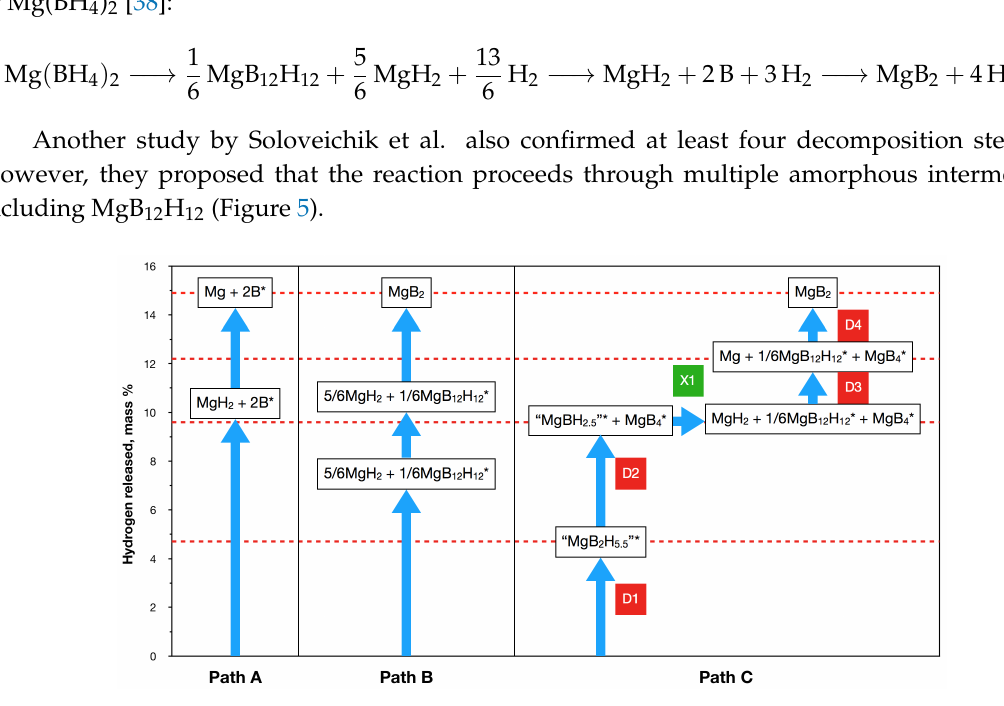
Figure 5. Decomposition pathways of Mg(BH 4 ) 2 , reproduced from Soloveichik et al. (Path C), where D1–D4 indicate hydrogen evolution events measured by temperature programmed desorption (TPD) [76]. Path A [37,77] proposed by Matsunaga et al. and Path B [38] proposed by Li et al. refer to mechanisms described in previous publications. Amorphous phases are denoted by an asterisk, observed hydrogen evolution steps are marked by dashed red lines. Reproduced from